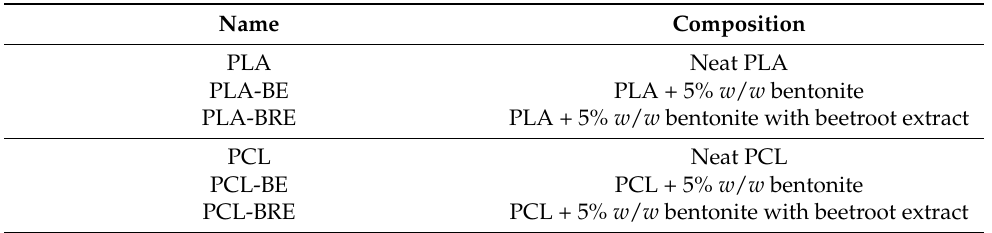
Figure 15. Preparation method of the samples. Table 5. Composition of the prepared samples.